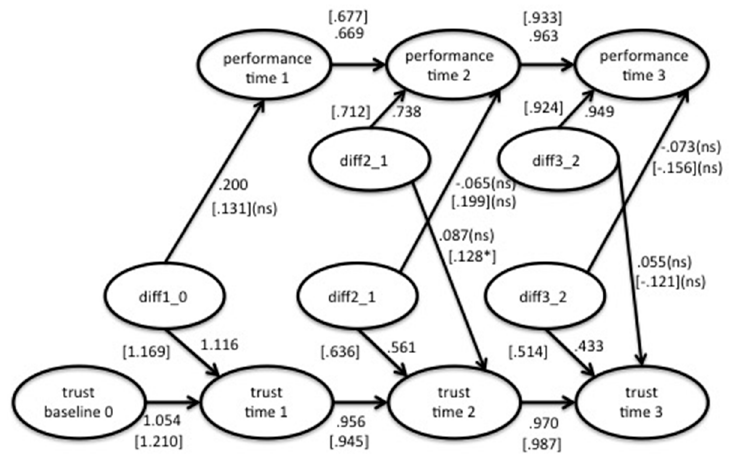
Figure 5. Bivariate coupling model. Latent change in trust influencing performance and change in performance influencing trust. Standardized parameter estimates for affective trust are not bracketed; those for cognitive trust are given in brackets. All estimates are significant p < 0.01 unless otherwise noted. * p < 0.023, parameter estimate from parsimonious solution, model H in Table 5. For clarity, the measurement model and indicator specific latent variables are not presented. Table 5. Examining the relationship between changes in affective and cognitive trust and performance.